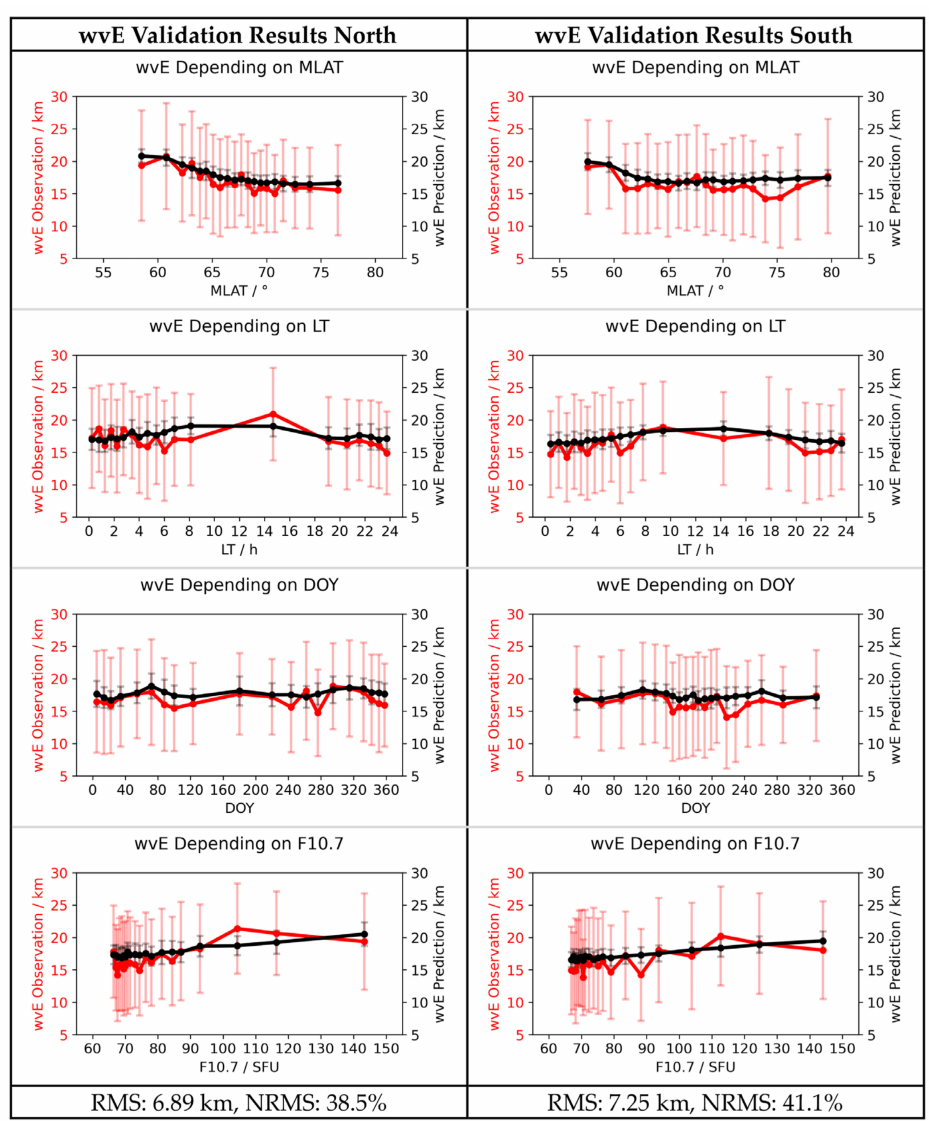
Figure 8. Observed (red) and predicted (black) wvE trends for the test dataset. ( Left ) Northern Hemi- sphere. ( Right ) Southern Hemisphere. Last row: RMS and NRMS deviation between observation and